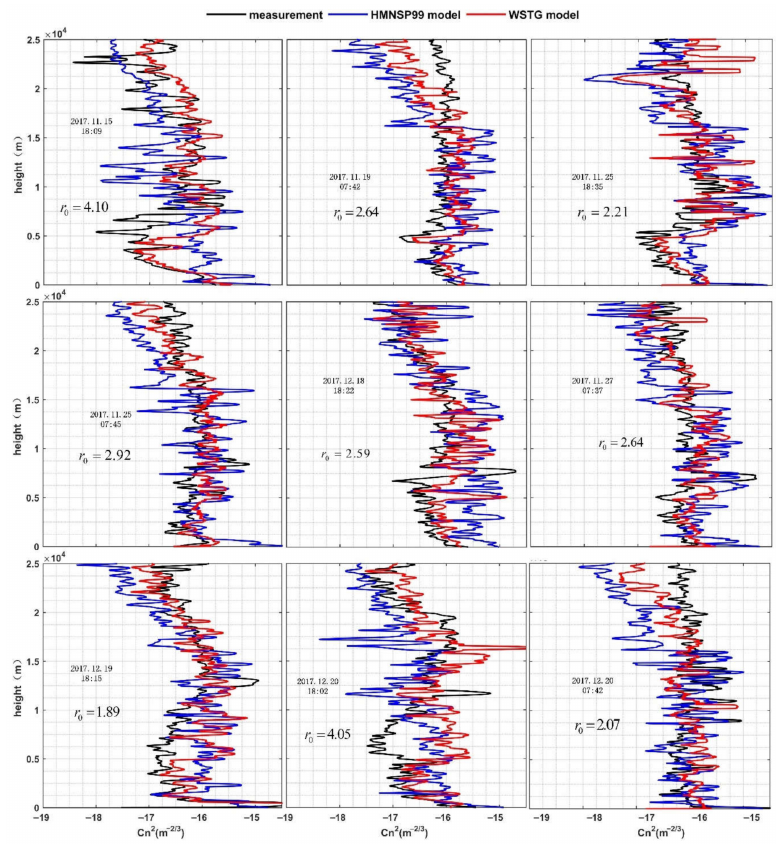
Figure 8. Comparison between estimated C 2 n profiles using the HMNSP99 model (blue), the WSTG model (red), and the measured profiles (black).